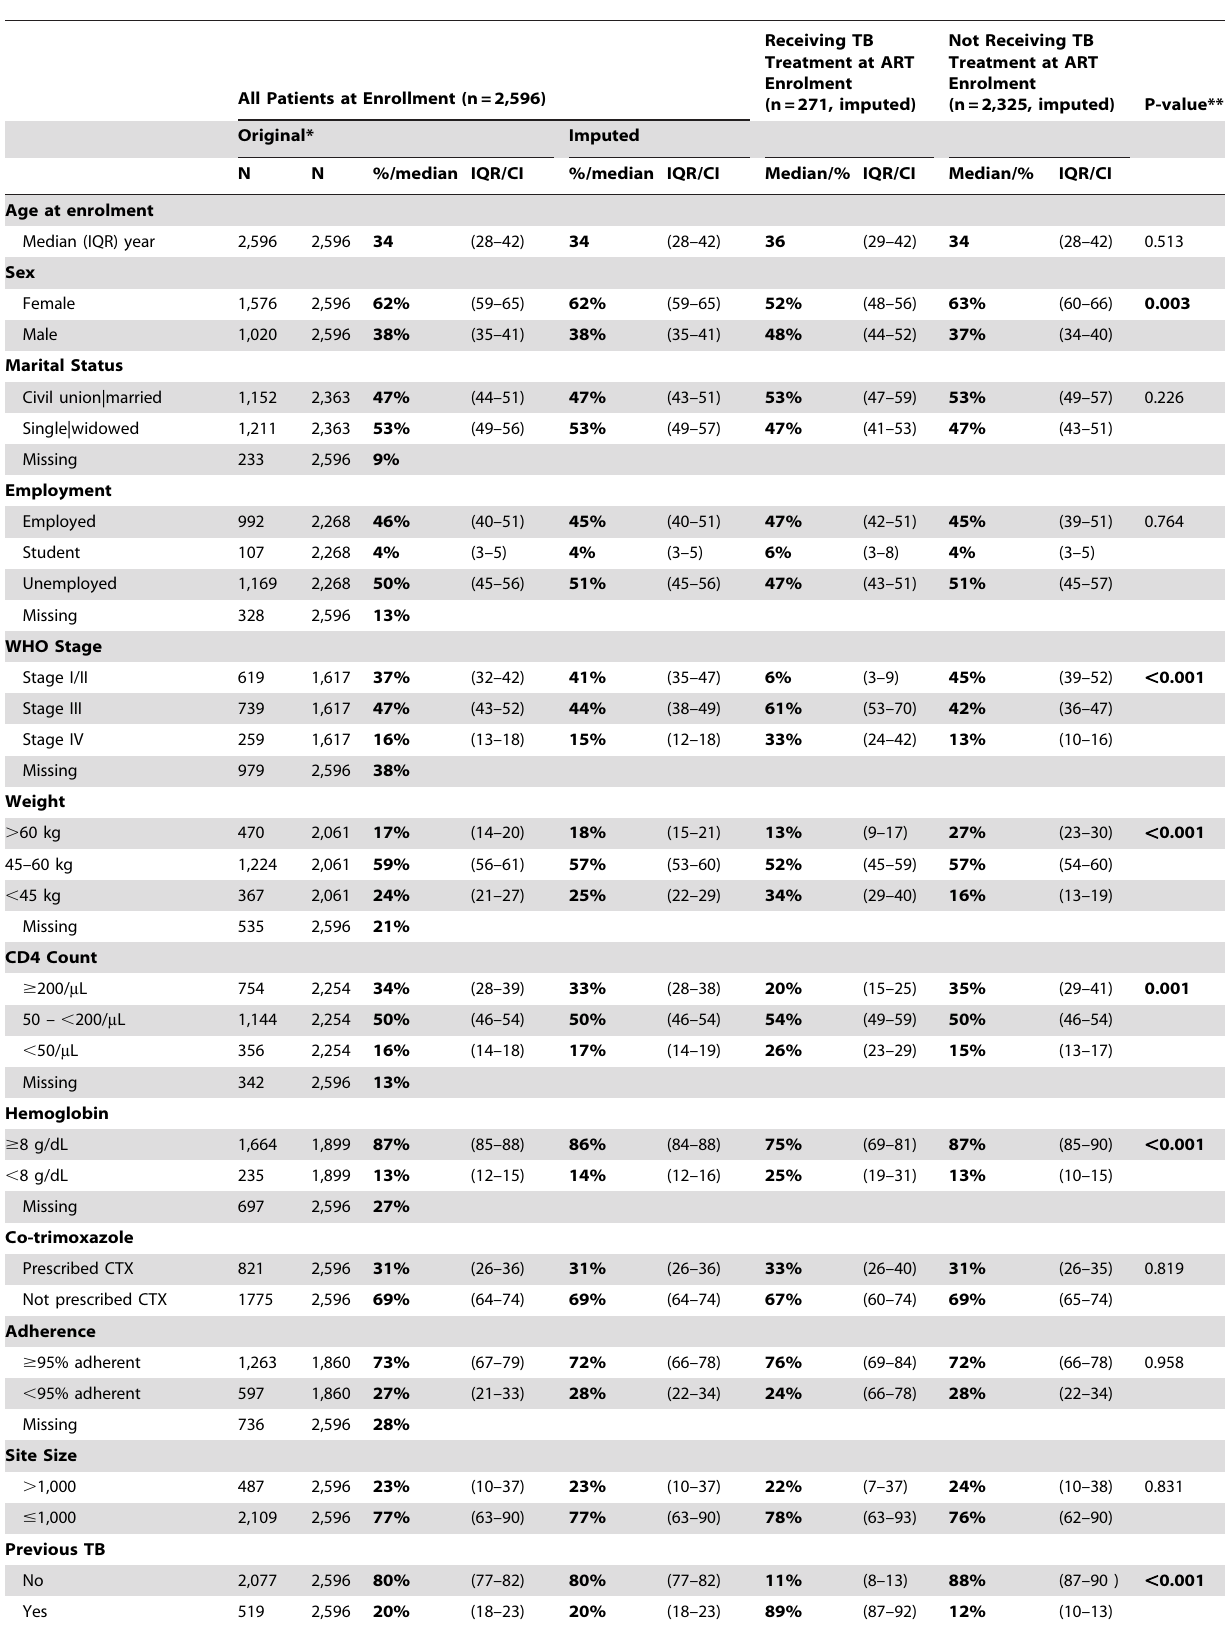
Table 1. Associations between Patient Characteristics and Prevalence of Active TB at ART